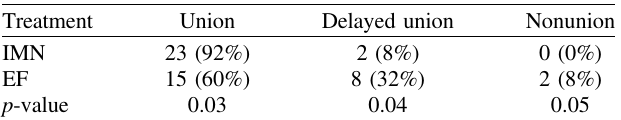
Table 3. Progress to union at three months postoperatively in the IMN and EF